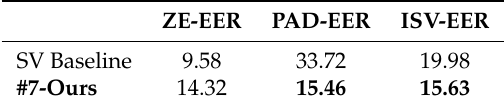
Table 6. Comparison of the SV baseline, our proposed modular deep neural network (DNN), and other work using the official trials for the ISV task. Numbers in bold represent the best